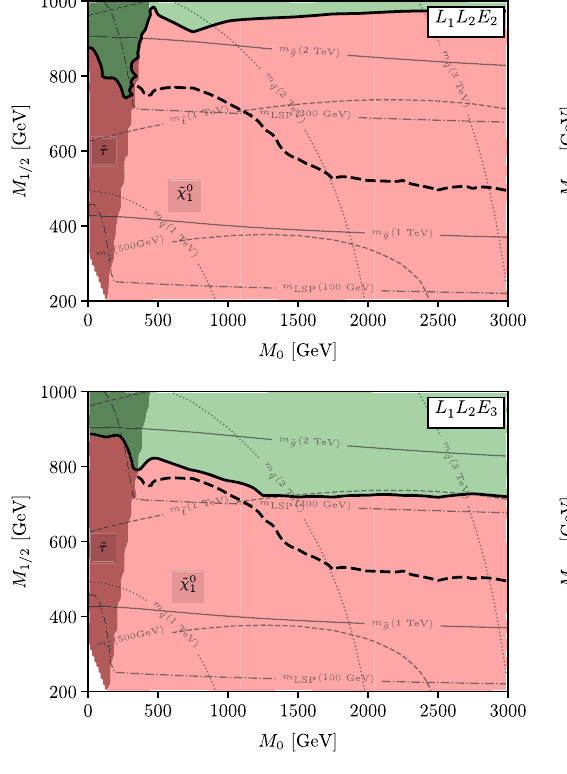
Fig. 12 Interpreting the LHC experimental searches as exclusion exclusion line of Fig. 11 (thick solid black curve there) is shown here as regions of LL ¯ E , (cid:6) (cid:5) R –CMSSM in the M 0 – M 1 / 2 plane using a thick dashed black curve for comparison. It does not extend into the p ˜ τ -LSP region, as that is not viable in the RPC–CMSSM. The figure on CheckMATE , and focusing on the cases λ 122 and λ 123 . The other CMSSM parameters are as in Fig. 11. In the upper-left-hand plot, cor- the upper right shows in thick solid black the CheckMATE exclusion responding to a λ 122 model, regions below the thick solid black line from the upper-left plot, as well as the RPC exclusion from Fig. 11. It furthermore shows which LHC analysis implemented in CheckMATE are excluded, and colored in red. Parameter regions above the thick is most sensitive, at a given parameter region, using the color code of black solid line are allowed by CheckMATE and colored in green. The Fig. 10. The lower two plots are as the upper except for turning on λ 123 dark red and dark green regions have a ˜ τ LSP, which is viable in the (cid:6) (cid:5) ˜ χ 0 LSP. instead of λ 122 . The small white area at very low M 0 and M 1 / 2 is where R p –CMSSM. The light red and light green regions have a 1 The light gray iso-mass curves are as in Fig. 11. The RPC–CMSSM the lightest stau becomes